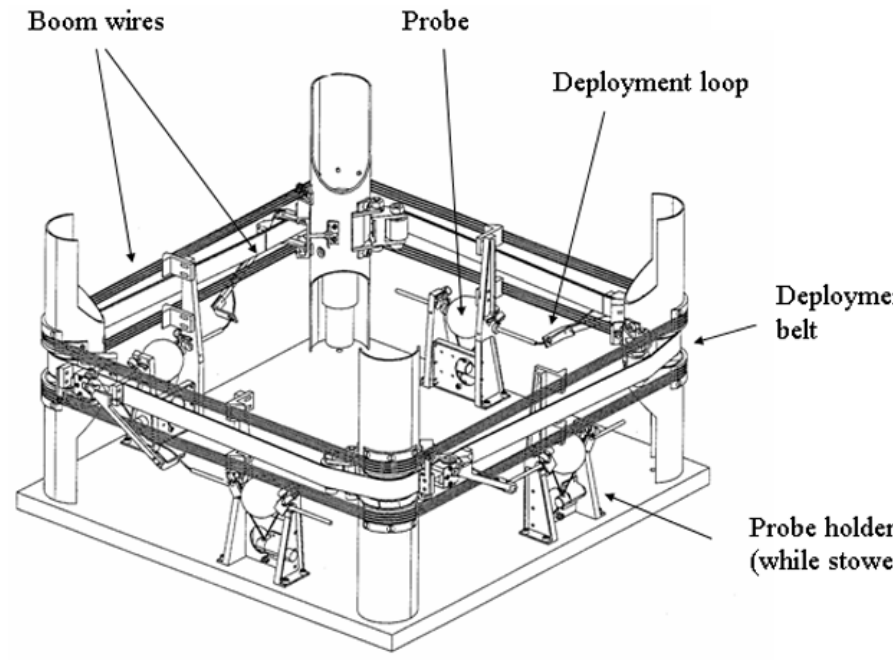
Fig. 2. EMMA wire boom